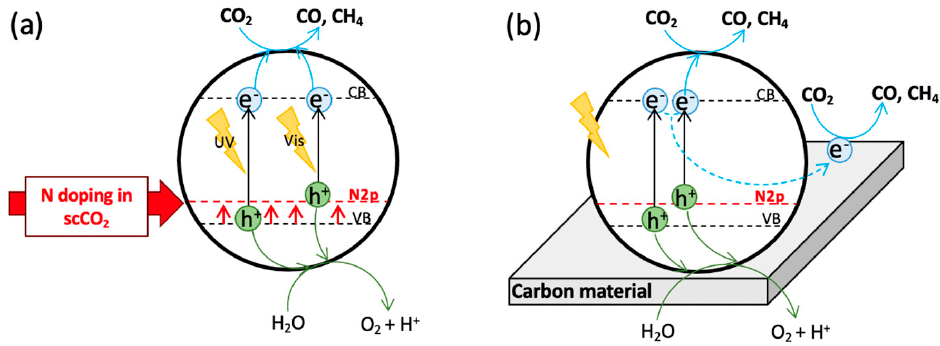
Figure 2. Photocatalytic mechanism: ( a ) N–doped TiO 2 nanoparticles, ( b ) N–doped TiO 2 /carbon support composites.